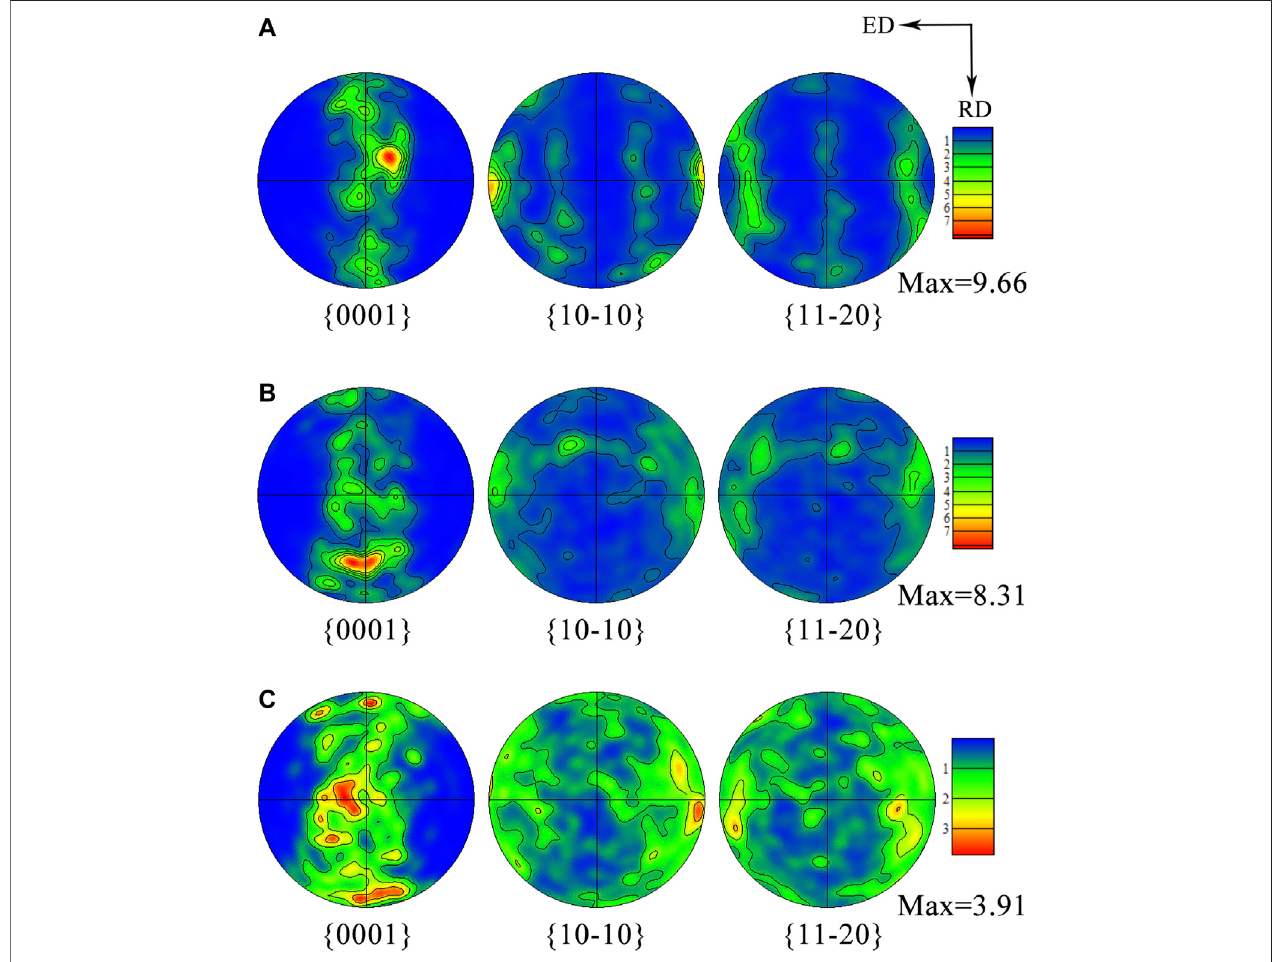
FIGURE 10 | Pole fi gures of the LAY410 alloy at the same rate with different temperatures: (A) T (cid:2) 150 ° C, (B) T (cid:2) 200 ° C, (C) T (cid:2) 250 ° C.